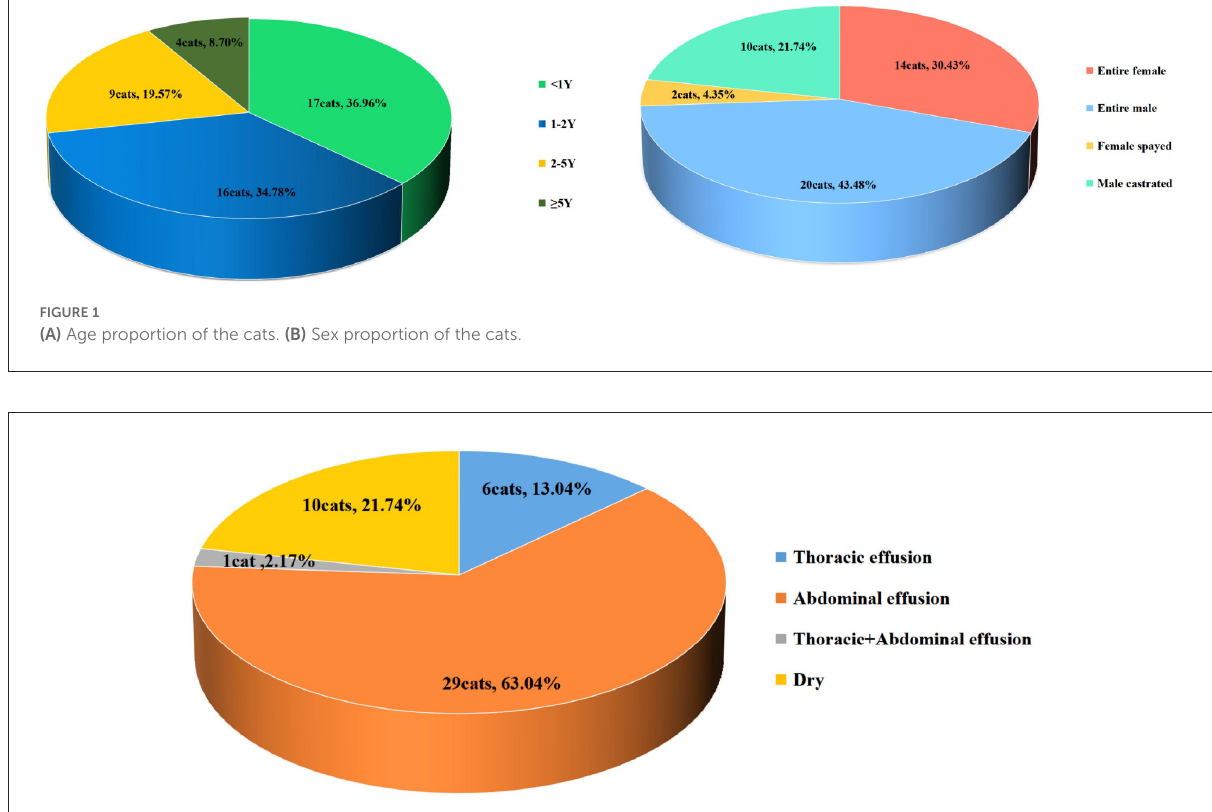
FIGURE2 The pie chart shows the number and proportion of different clinical forms of infectious peritonitis (FIP) in cats from the 4